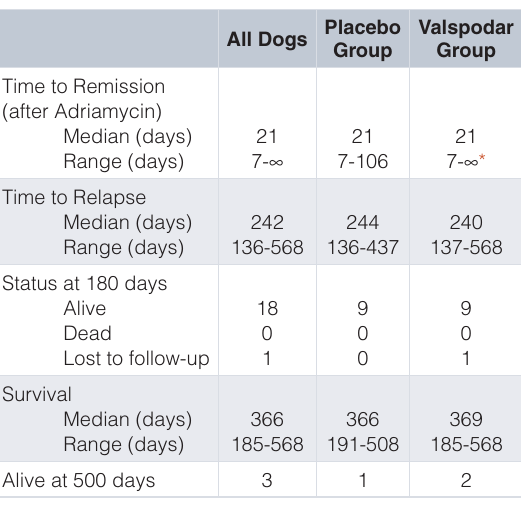
Table 6. Clinical